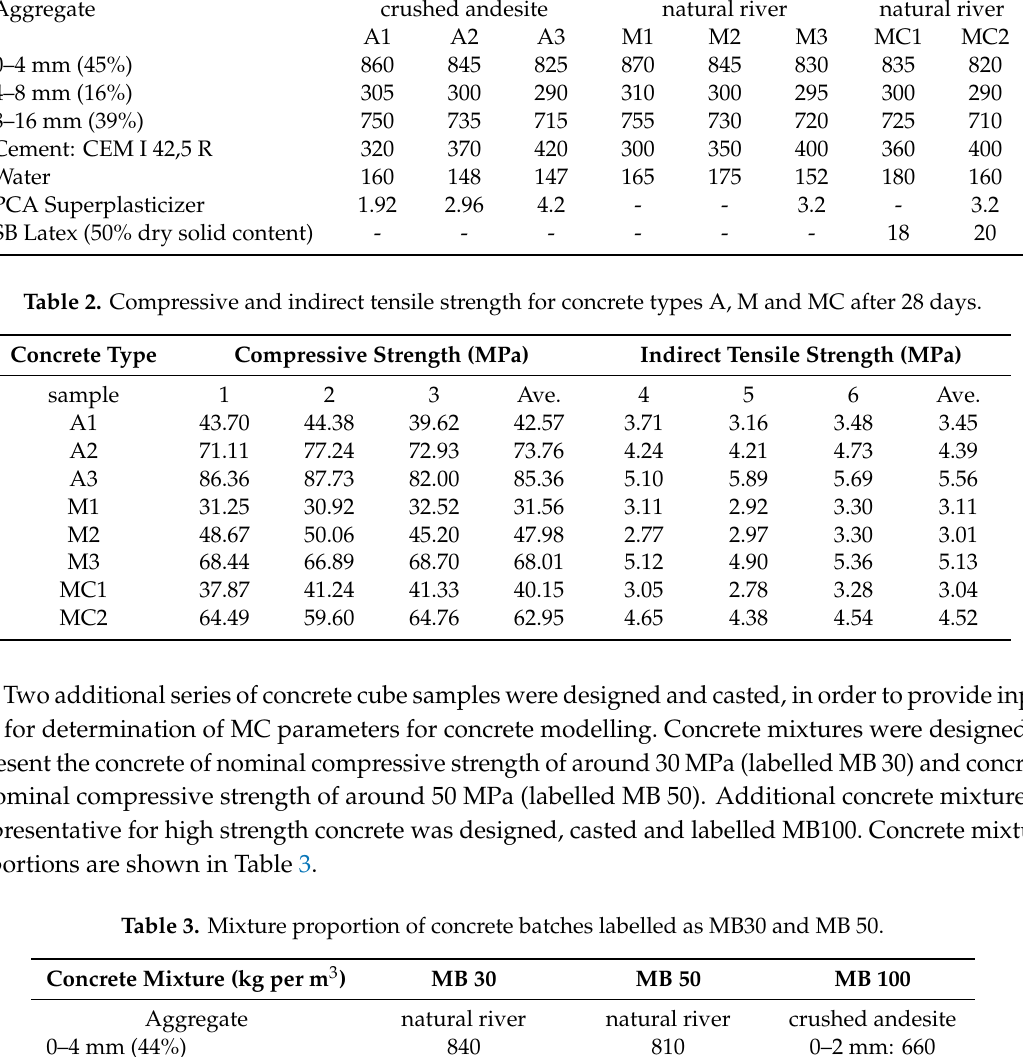
Table 3. Mixture proportion of concrete batches labelled as MB30 and MB 50.